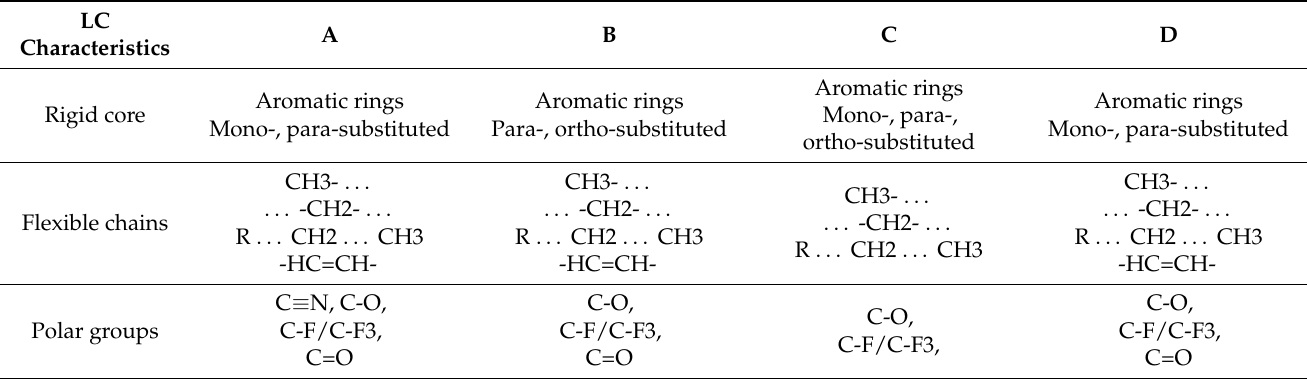
Table 2. Correspondence between general LC characteristics and results from FTIR and 1 H NMR analysis of EOL-LCDs A, B, C and D.